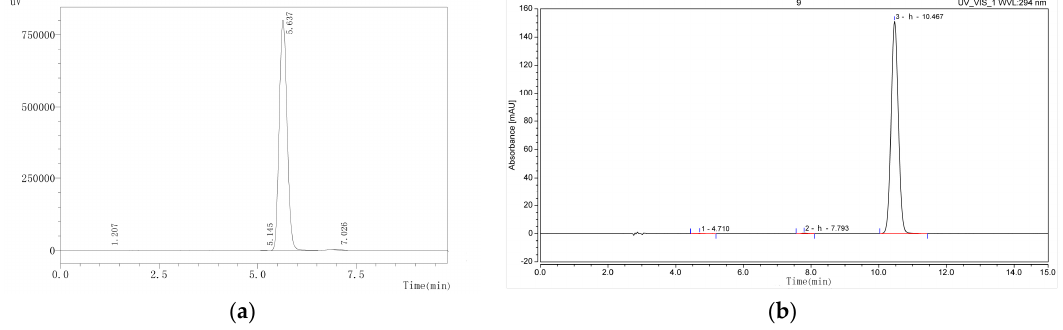
Figure 1. The HPLC chromatogram of magnolol and honokiol. ( a ) Magnolol; ( b ) honokiol.